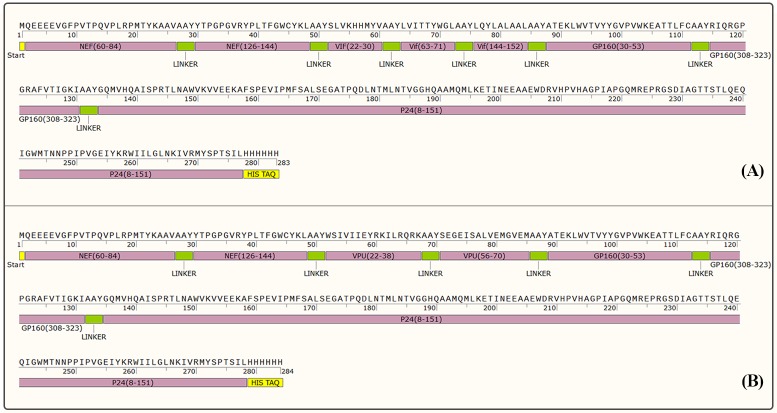
The design of polyepitope peptide constructs.(A) The Nef-Vif-Gp160-P24 polyepitope construct; (B) The Nef-Vpu-Gp160-P24 polyepitope construct.